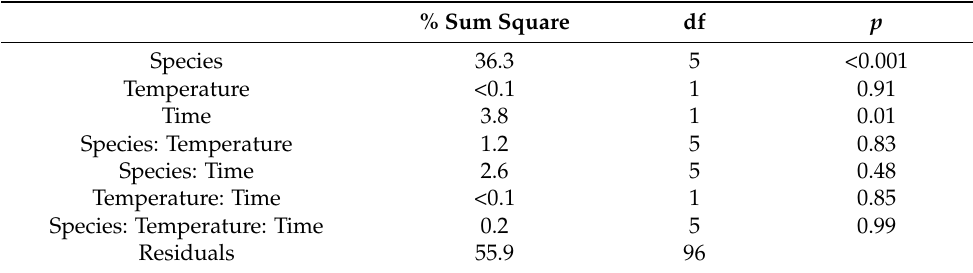
Figure 1. Mean number of individuals (± 95% CI) at the beginning and end of the experiment for six species exposed to two temperature treatments (T0 = ambient temperature, T3 = 3 °C experimental warming) over 20 weeks. LUHE = Ludwigia hexapetala , MEAQ = Mentha aquatica , MYAQ = Myriophyllum aquaticum , MYSC = Myosotis scorpioides , EGDE = Egeria densa , POCR = Potamogeton crispus . Small letters indicate differences among species, and capital letters indicate difference between the beginning and the end of the experiment. NS = Not Significant (Three-way ANOVA, n = 5). See detailed credits for plant images in Supplementary Material 1. Table 1. ANOVA and Tukey HSD test results for the number of individuals of six species exposed to two temperature treatments over 20 weeks.